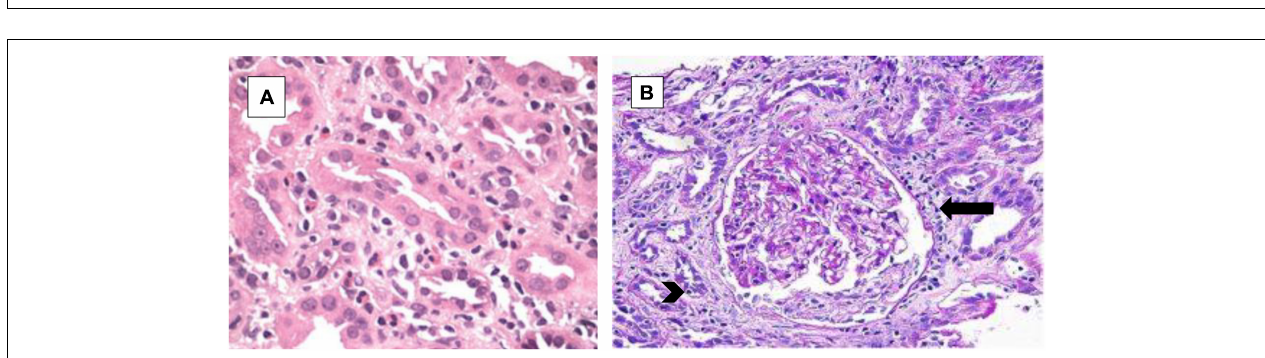
FIGURE 1 | Creatinine trend. ATIN, Acute tubulointerstitial nephritis.